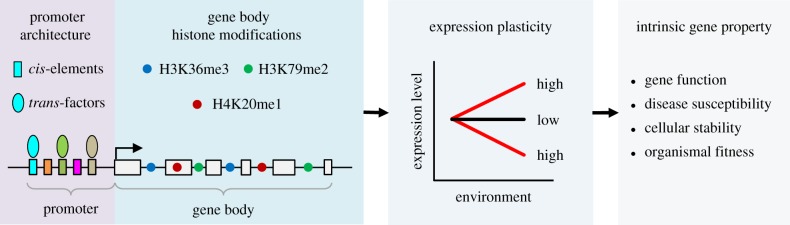
Summary of findings. Gene structure is illustrated by linked grey boxes with an arrow indicating the TSS. Rectangles indicate cis-elements and coloured ovals depict regulatory proteins binding in the promoter region. Circles indicate gene body histone modifications.